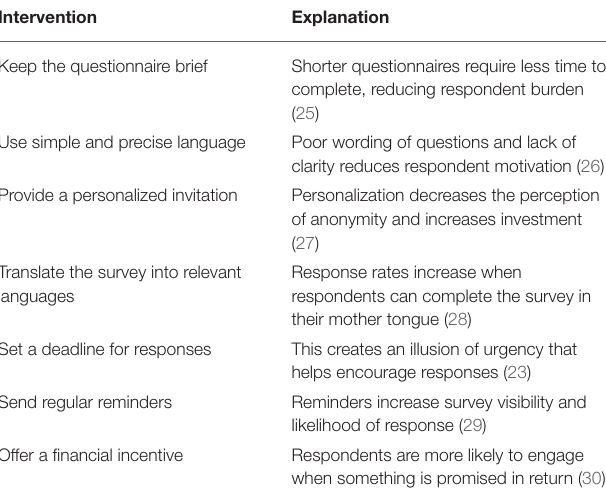
TABLE 4 | Interventions proven to increase response